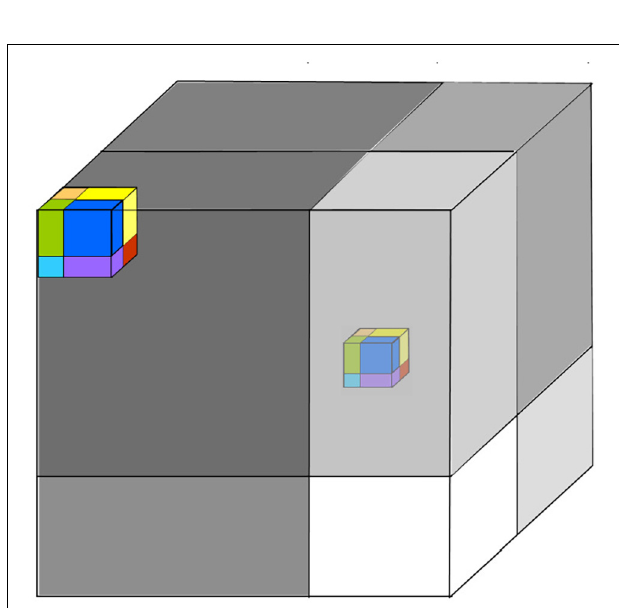
FIGURE 9 | On a short timescale, the initial three axes are represented by a set of species in a compact niche, this changes and the cube moves around the hypercube on longer